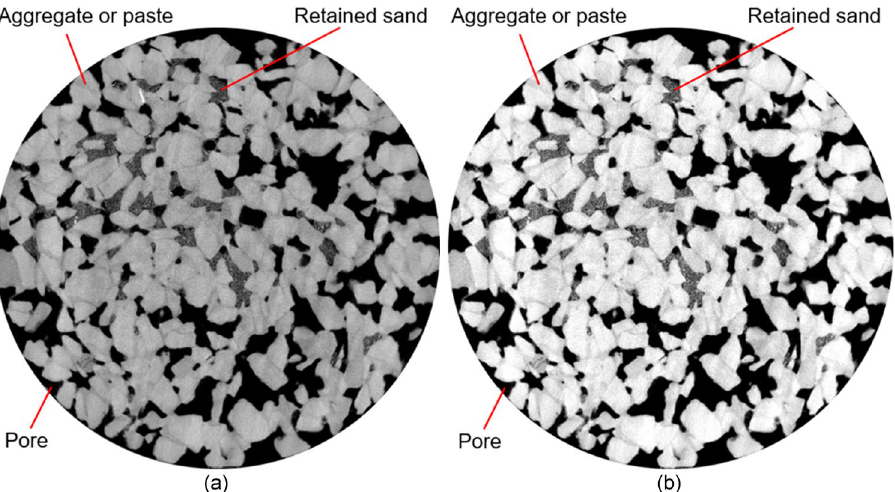
Figure 3. Images processing procedures for sand-clogged samples: ( a ) images cropping and ( b ) images contrast enhancement. The pore was darkest in colour, followed by the retained sand and then the aggregate (or cementitious paste).